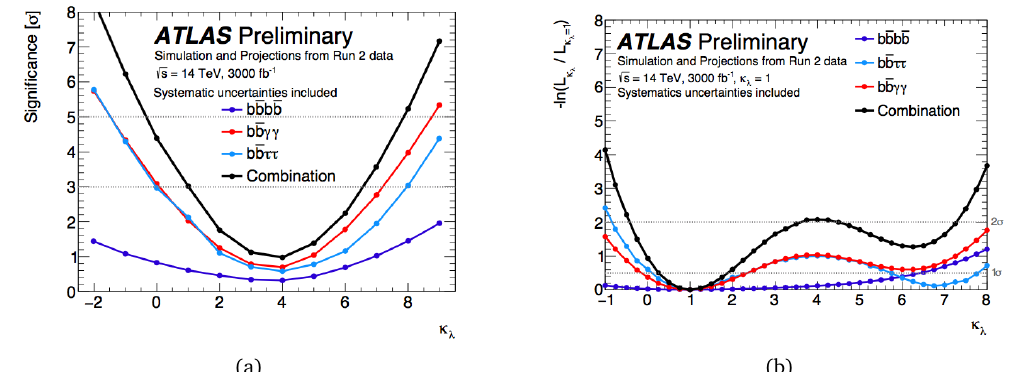
Figure 4: Expected significance for the di-Higgs signal as a function of κ λ (a) and expected negative natural logarithm of the ratio of the maximum likelihood for κ λ to the maximum likelihood for κ λ = 1 (SM) (b) [ 25 ]